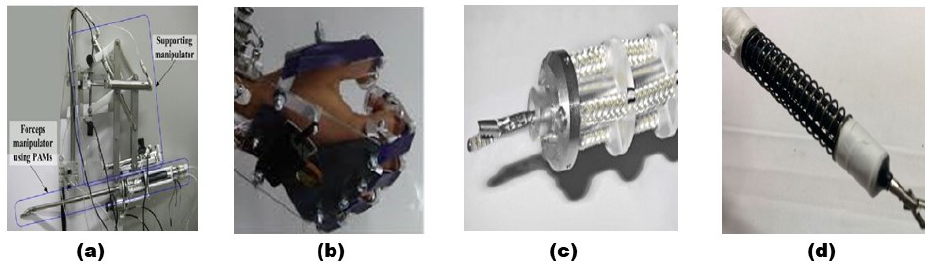
Figure 14. Applications of PAMs in medical instrumentation: ( a ) Forceps’ manipulator for laparo- scopic surgery [59]; ( b ) Wearable hand exoskeletons [171]; ( c ) Instrument for keyhole surgery [85]; ( d ) End-effector with forceps